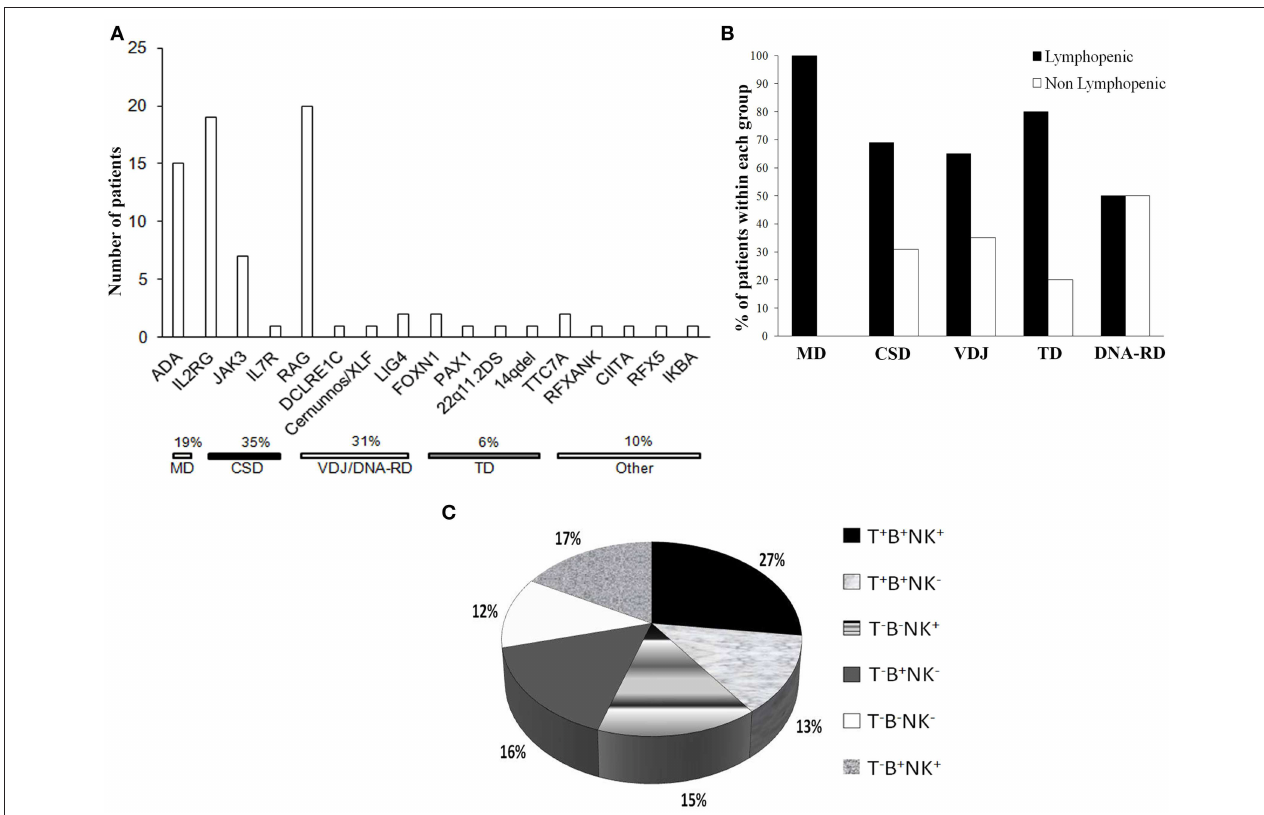
FIGURE 3 | Genetic causes and immunophenotype of the cohort. (A) Histogram distribution of the genetic defects underlying SCID. The pathogenic mechanisms implicated are indicated. ADA , adenosine deaminase; IL2RG , interleukin 2 receptor gamma; JAK3 , Janus kinase 3; IL7R, interleukin 2 receptor; RAG , recombinase-activating genes; LIG4 , DNA Ligase IV; FOXN1 , Forkhead Box N1; PAX1, Paired Box Gene 1; TTC7A, Tetratricopeptide Repeat Domain-Containing Protein 7A; RFXANK, Regulatory Factor X, Ankyrin Repeat-Containing; CIITA, Class II Transactivator; RFX5, Regulatory Factor X; IKBA, NFKB inhibitor alpha. (B) Proportion of lymphopenic or non lymphopenic patients according to the pathogenic group. (C) Distribution of the cohort according the immunophenotype, expressed as percentage